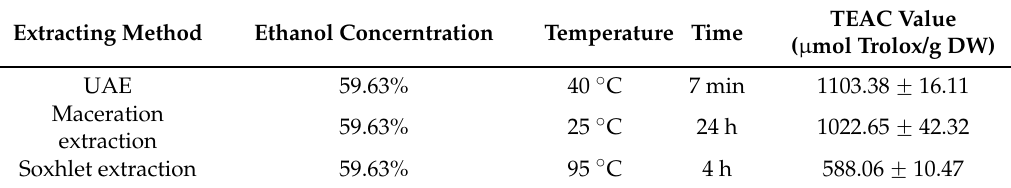
Table 4. The comparison of UAE with maceration and Soxhlet extraction.